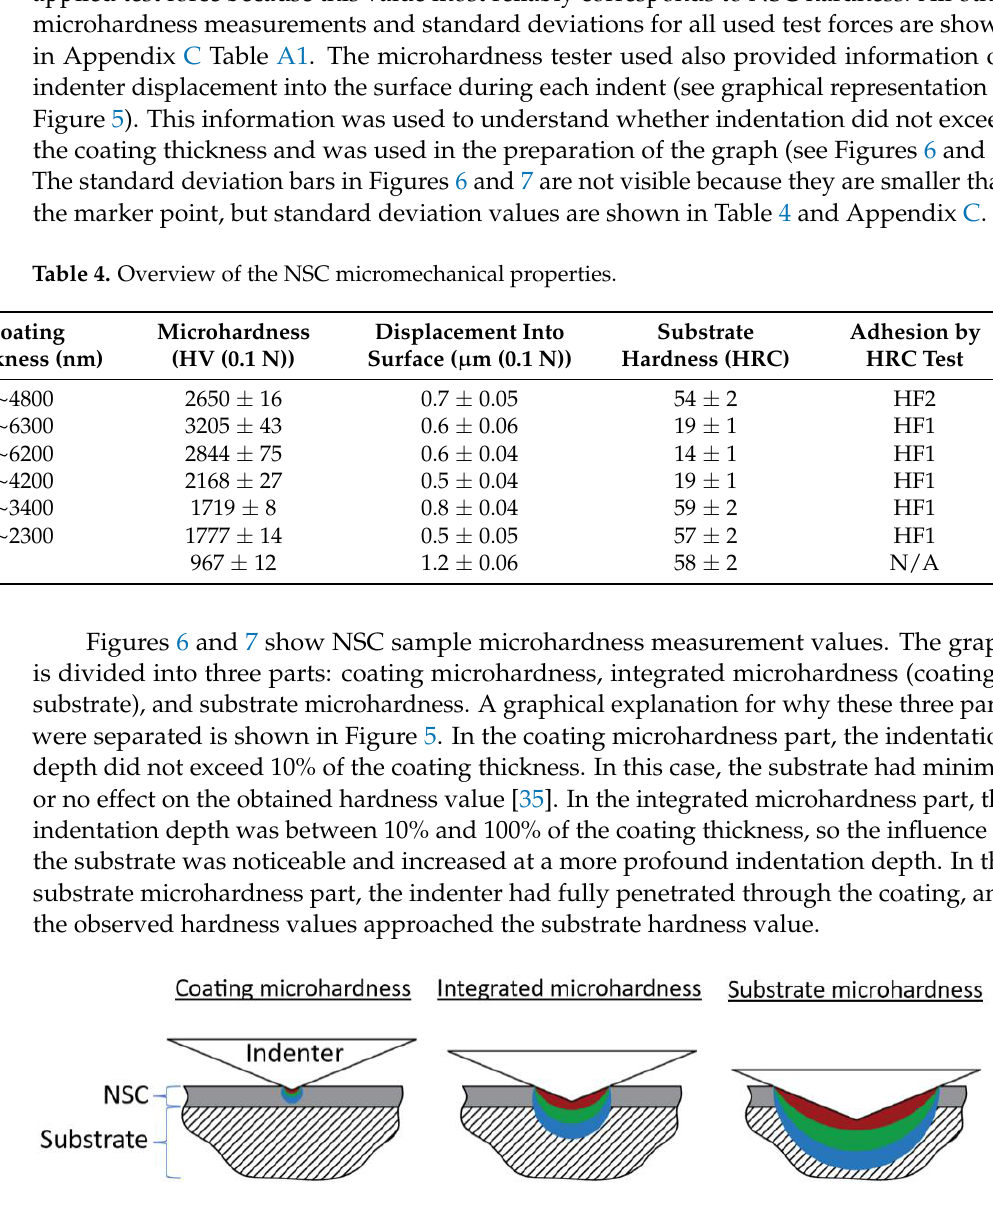
Table 4. Overview of the NSC micromechanical properties.